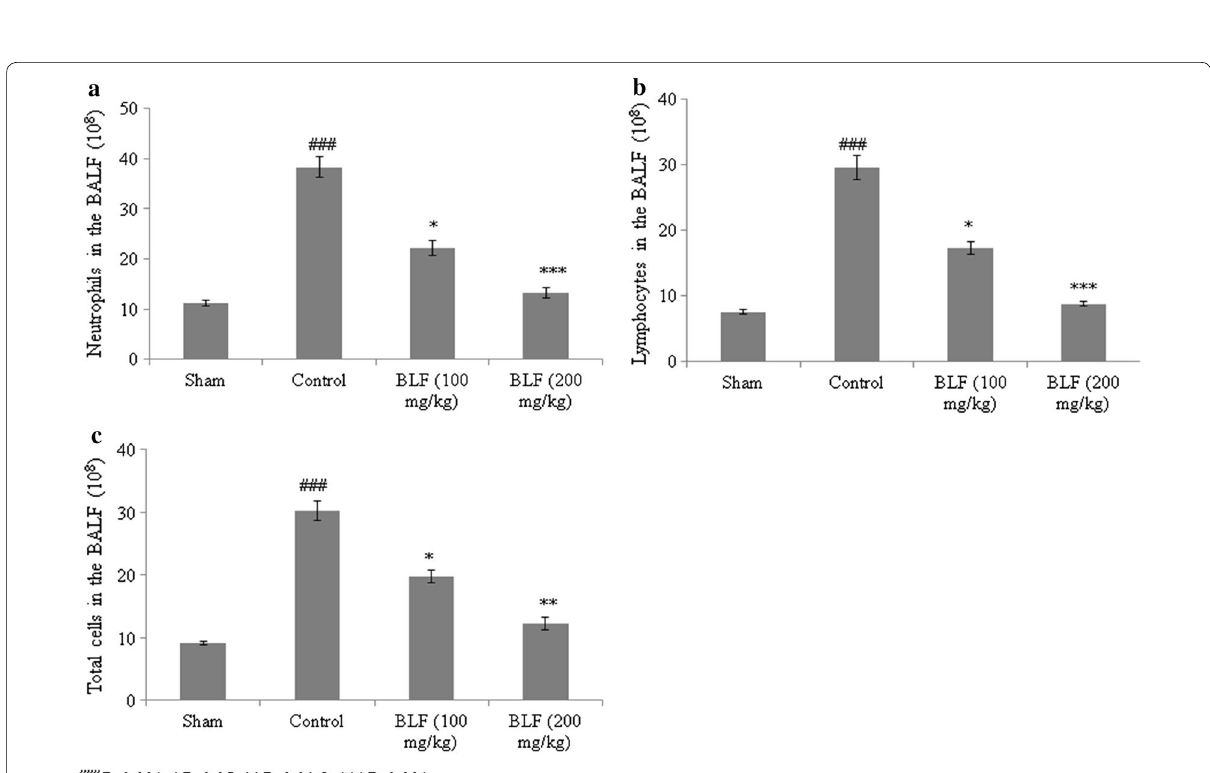
Fig. 5 BLF reduces neutrophils ( a ), lymphocytes ( b ) and total cell count ( c ) in ALI-induced male albino rats. Rats were given BLF for 30 consecutive days through oral gavage. ### P < 0.001 compared to the sham group; * P < 0.05 and *** P < 0.001 compared to control